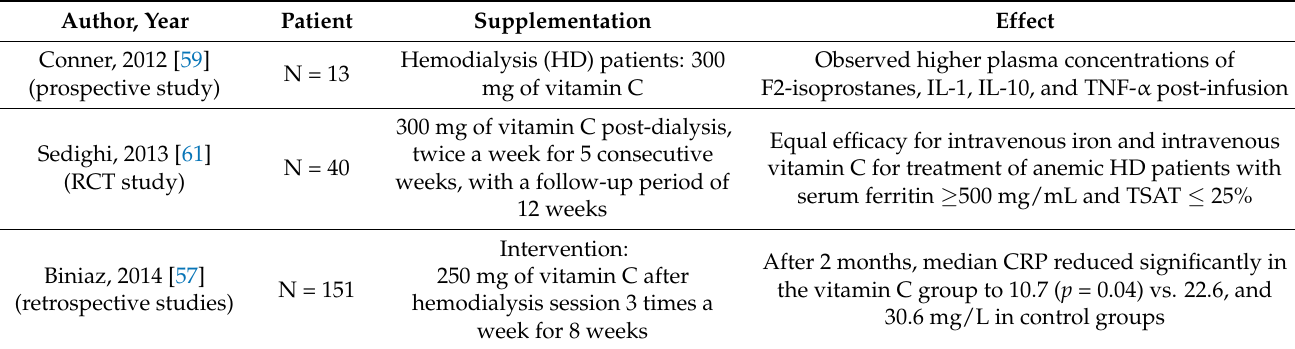
Table 1. Studies on ascorbic acid supplementation in